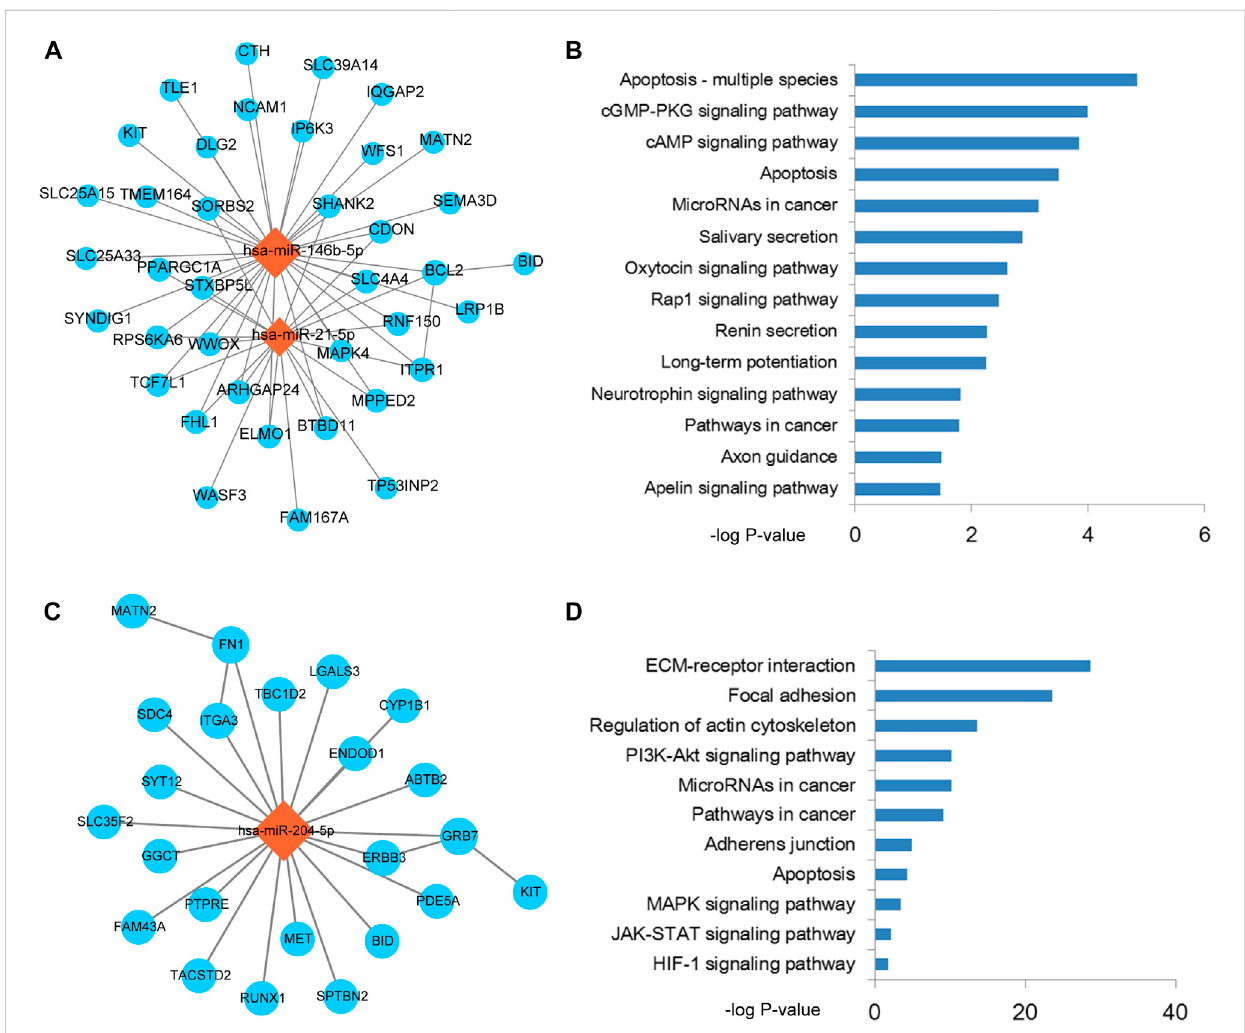
FIGURE 3 The functional modules of the miRNA-mRNA network. (A) Functional module 1 that identi fi ed from the miRNA-mRNA network by MCODE. (B) Pathway enrichment results of the mRNAs in module 1. (C) Functional module 2 that identi fi ed from the miRNA-mRNA network by MCODE. (D) Pathway enrichment results of the mRNAs in module